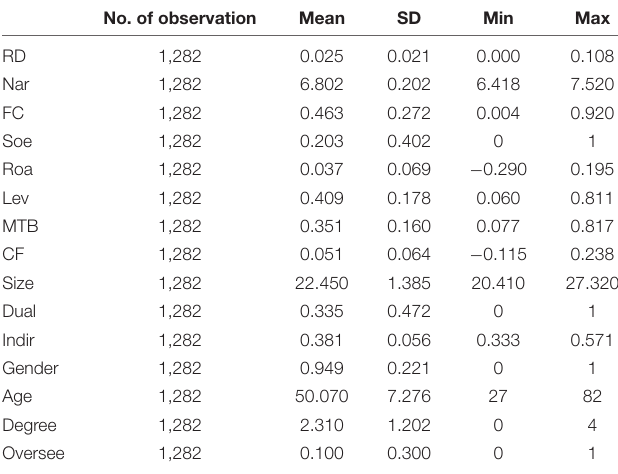
TABLE 2 | Descriptive statistical results of variables.